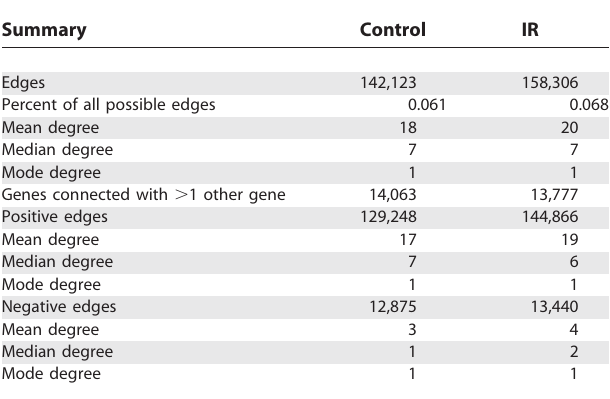
Table 2. Clique Summary